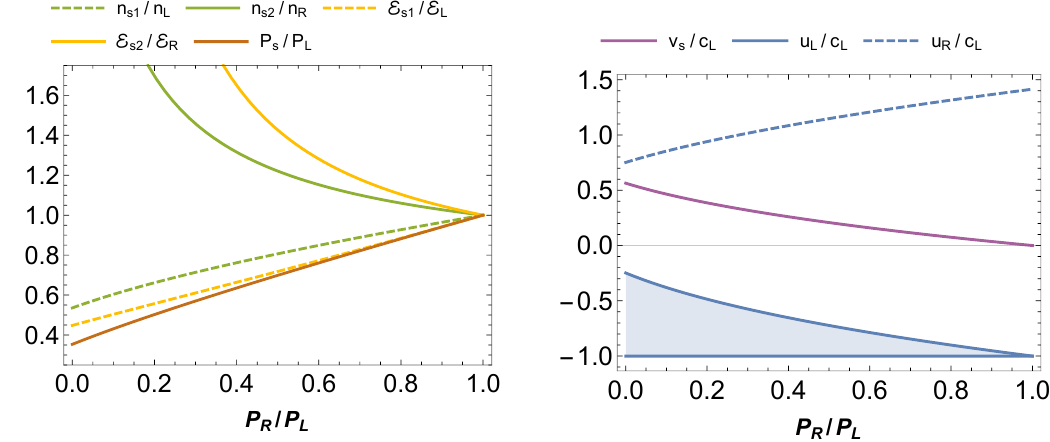
Figure 3. NESS variables for z = 2, d = 3 as a function of P R =P L for (cid:12)xed n L =n R = 2. Left panel: steady state pressure P s , charge densities n s 1 ;s 2 , and energy densities E s 1 ;s 2 . Right panel: (cid:13)ow speed v s , shock speed u R , and wave speed u L across rarefaction pro(cid:12)le.